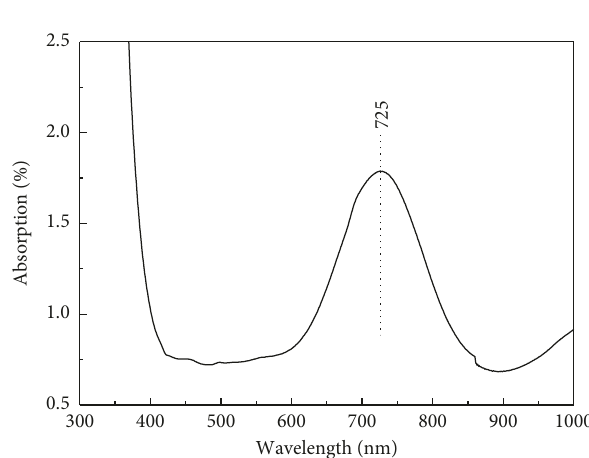
Figure 4: UV-Vis spectrum of the tourmaline